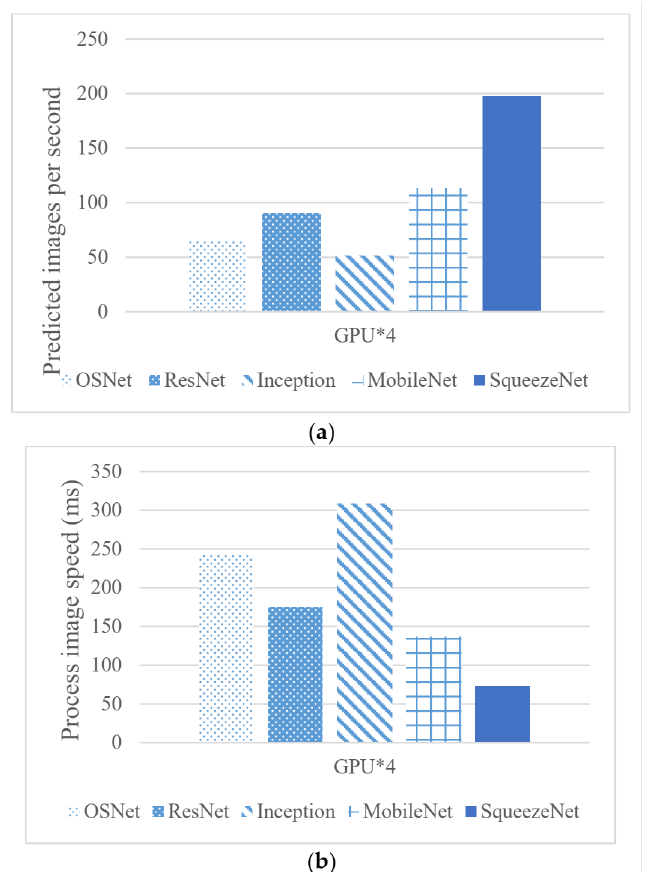
Figure 12. Re-ID default model performance test results: ( a ) number of images analyzed per second and ( b ) image processing time in